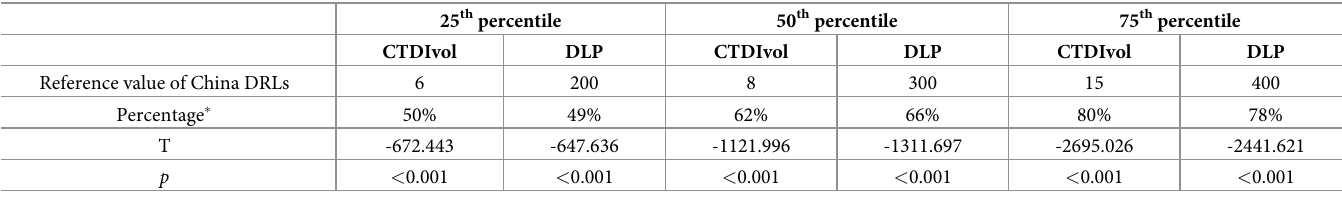
Table 4. Comparison between CTDIvol and DLP in our study with China